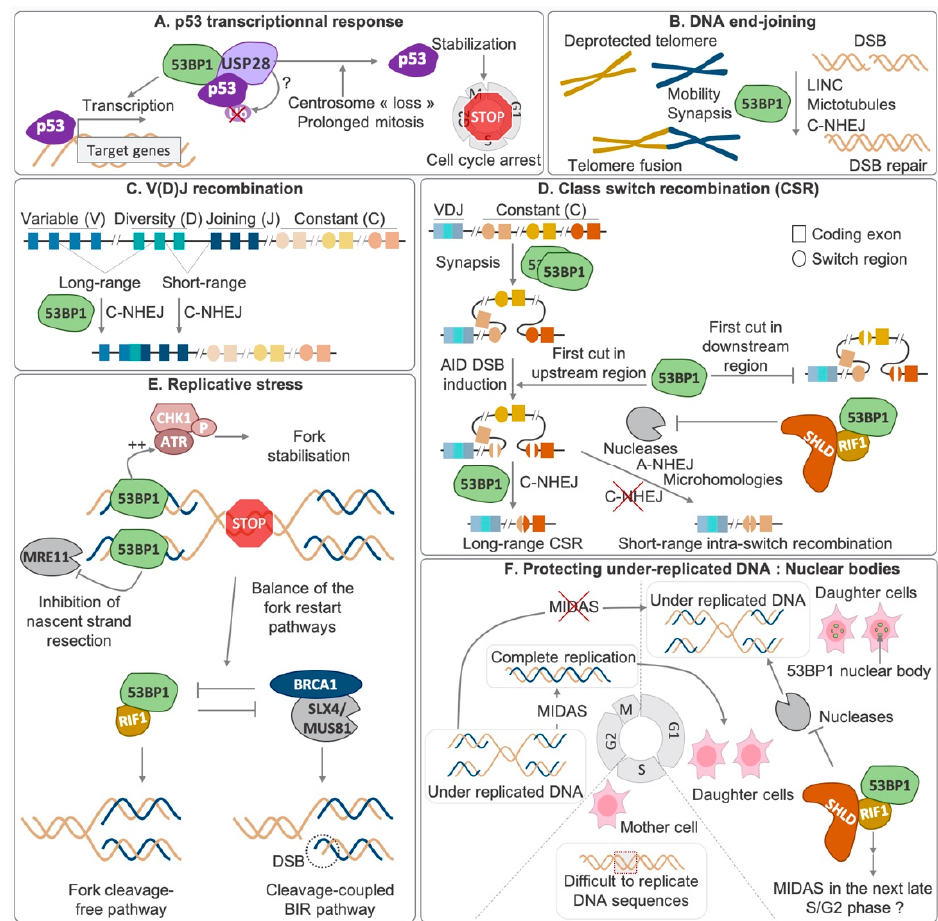
Figure 2. Implication of 53BP1 in biological processes: 53BP1 has been implicated in ( A ) the p53 response in different settings; ( B ) C-NHEJ-dependent joining of DSB ends; ( C ) long-range V(D)J recombination; ( D ) multiple steps in CSR: loop formation between switch regions, regulation in the order of DSB induction by AID in switch regions and joining of C-NHEJ-dependent long-range CSR; ( E ) response to replicative stress and stalled fork restart; and ( F ) protecting underreplicated DNA from degradation in 53BP1 nuclear bodies (see text for details).